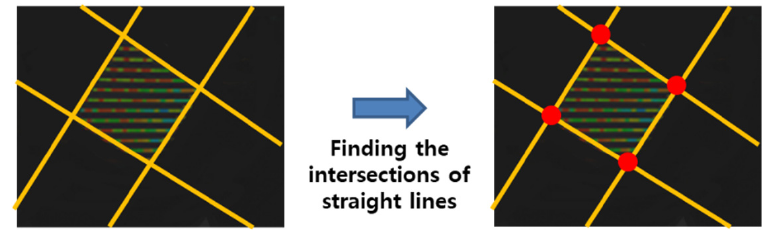
Figure 12. Four-lines filtering for pattern corners.